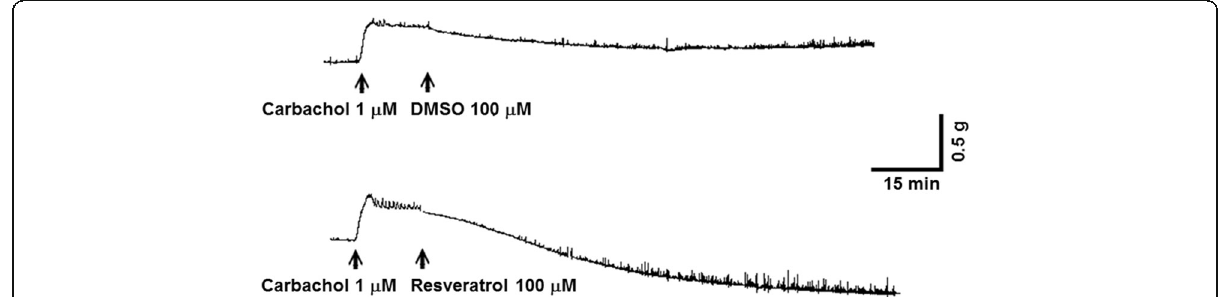
Fig. 1 Typical relaxant tracings of human gallbladder muscle strips induced by resveratrol. The arrows indicate the addition of carbachol, resveratrol and dimethyl sulfoxide